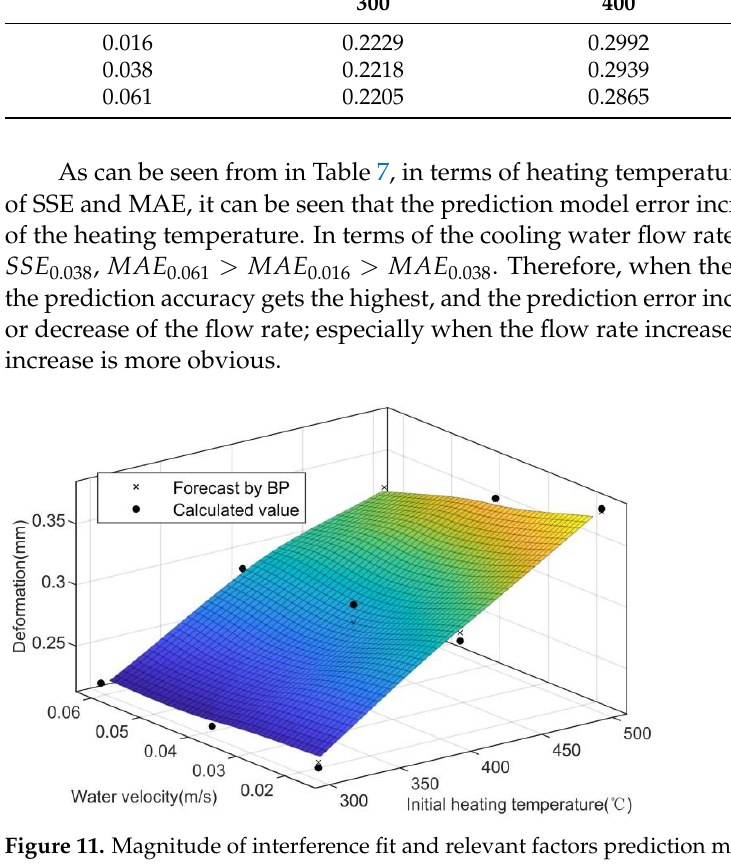
Table 7. The prediction model accuracy of BP.